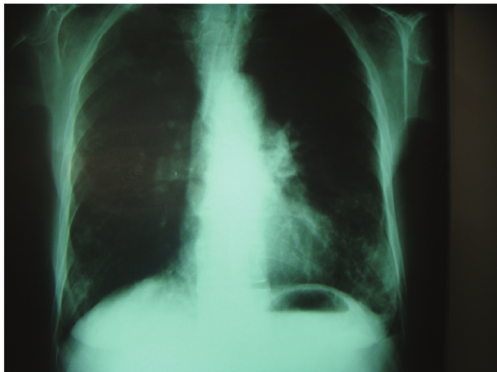
Figure 1: Chest X-ray: infiltration in the base of both lungs.